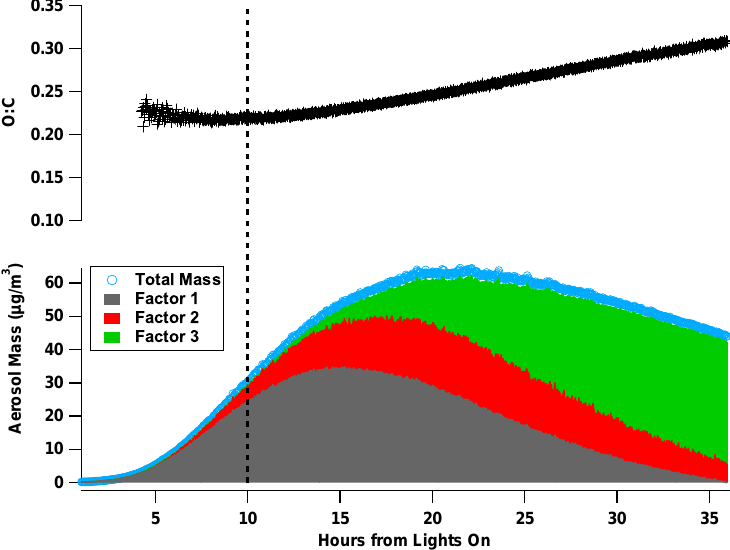
Fig. 6. Three-factor PMF solution, total organic mass, and O:C ratio. The dashed line denotes the point at which factor 3 grows in and the O:C begins to rise